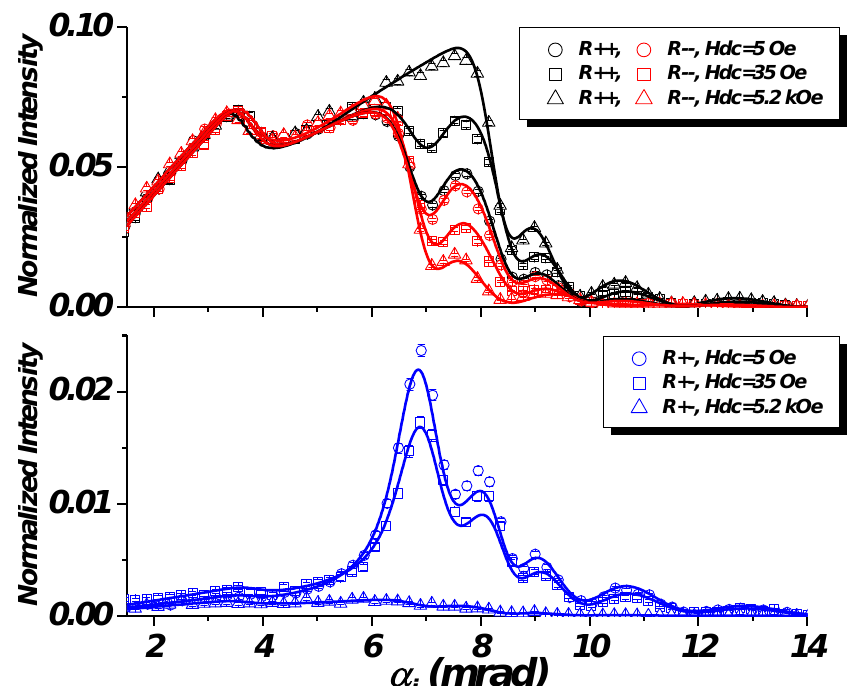
Figure 10. NSF and SF reflectivities plotted on a linear scale for the stripe array oriented parallel to the scattering plane and in different fields applied perpendicular to stripes. Symbols refer to experimental data; solid lines are best fits to the experimental